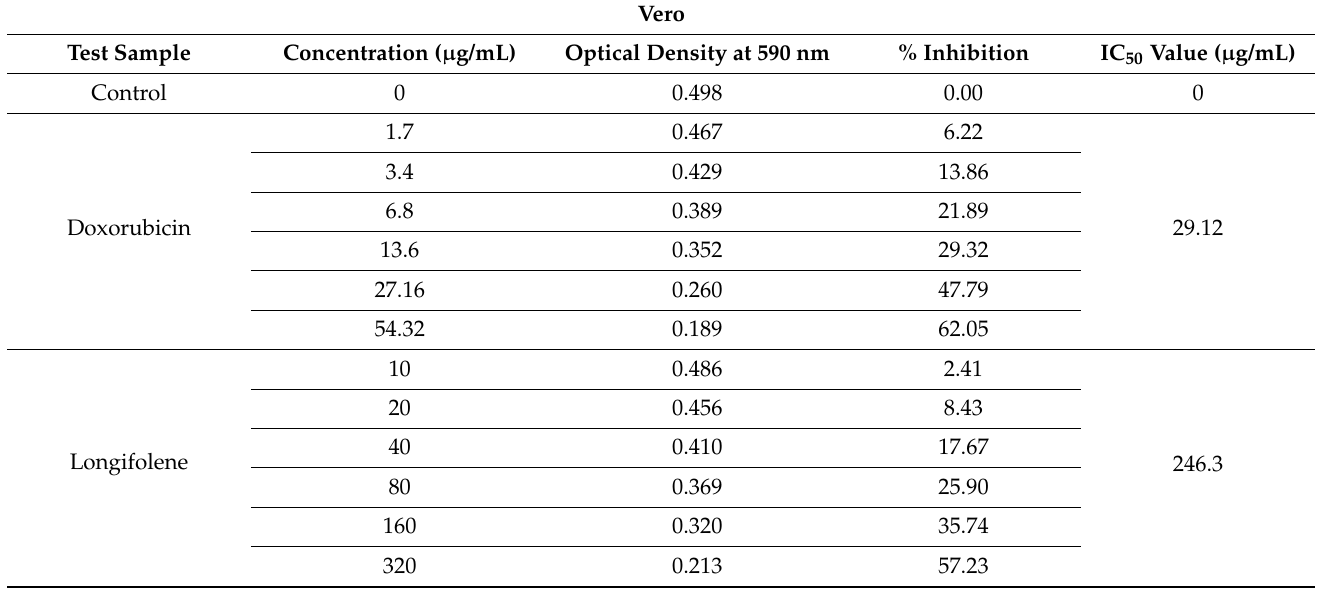
Table 3. MTT assay of doxorubicin and longifolene on Vero cell line. Vero